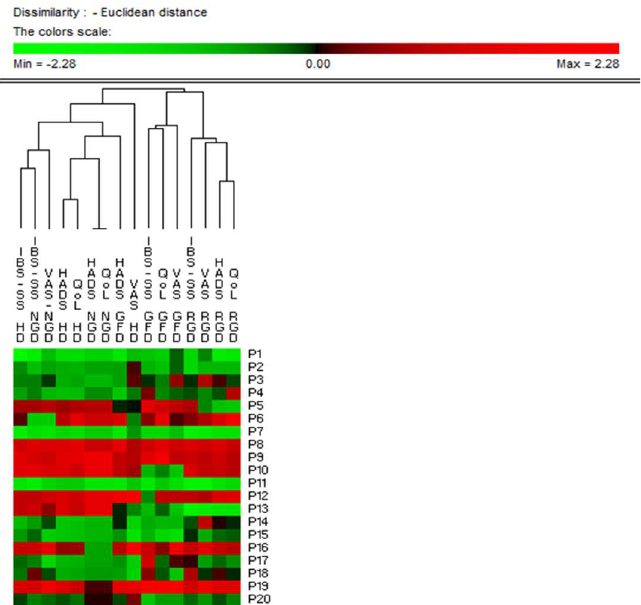
Figure 4. Permutation analysis based on clinical scores. Euclidean distance and McQuitty’s criterion were used for clustering. Cases (patients) were numbered from P1 to P20. Variables were reported as abbreviation of clinical scores (IBS-SS, Irritable Bowel Syndrome Severity Score; VAS, Visual Analogue Scale; HADS, Hospital Anxiety and Depression Scale; QoL, Quality of Life) plus the type of diet (HD, Habitual Diet; GFD, Run-in Open gluten-free diet; RGD, Reduced-gluten diet; NGD, Normal-gluten diet). Colours correspond to normalized mean data levels from low (green) to high (red).